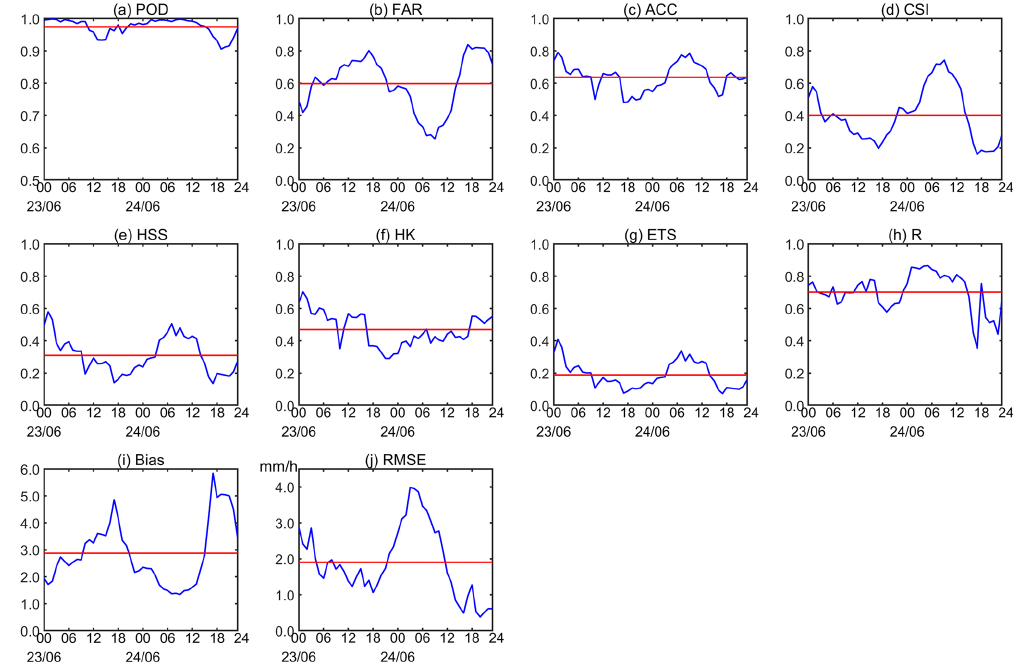
Figure 12. Time series of evaluation indicators of the QPE algorithm for all stations at each time: (a) POD; (b) FAR; (c) ACC; (d) CSI; (e) HSS; (f) HK; (g) ETS; (h) R ; (i) Bias; (j)